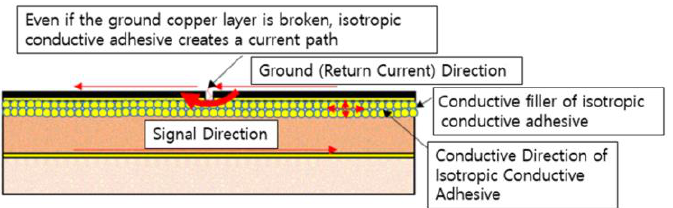
Figure 2. Image of a via crack due to delamination between CCLs caused by low flexibility.